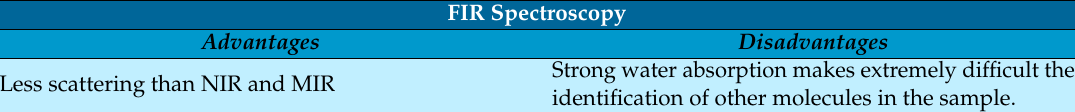
Table 12. Advantages and disadvantages of FIR